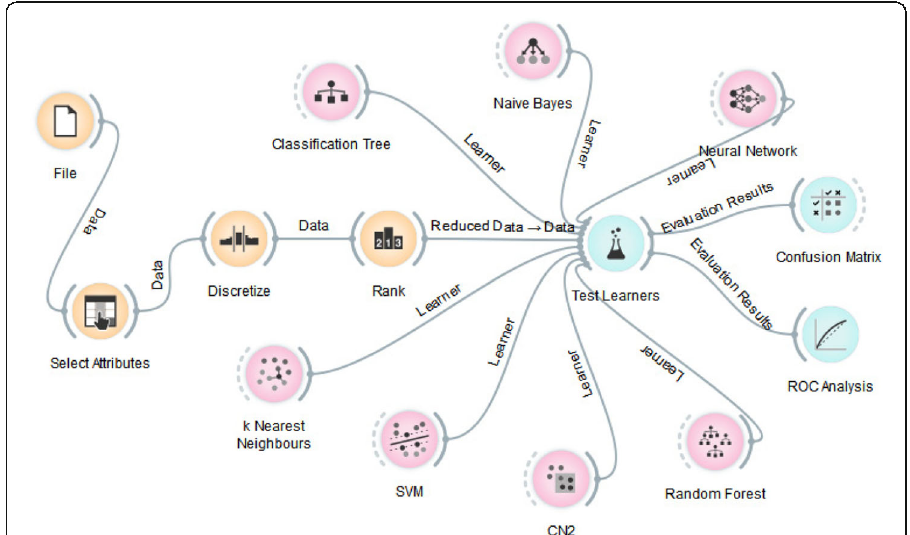
Fig. 2 Data Mining Analysis